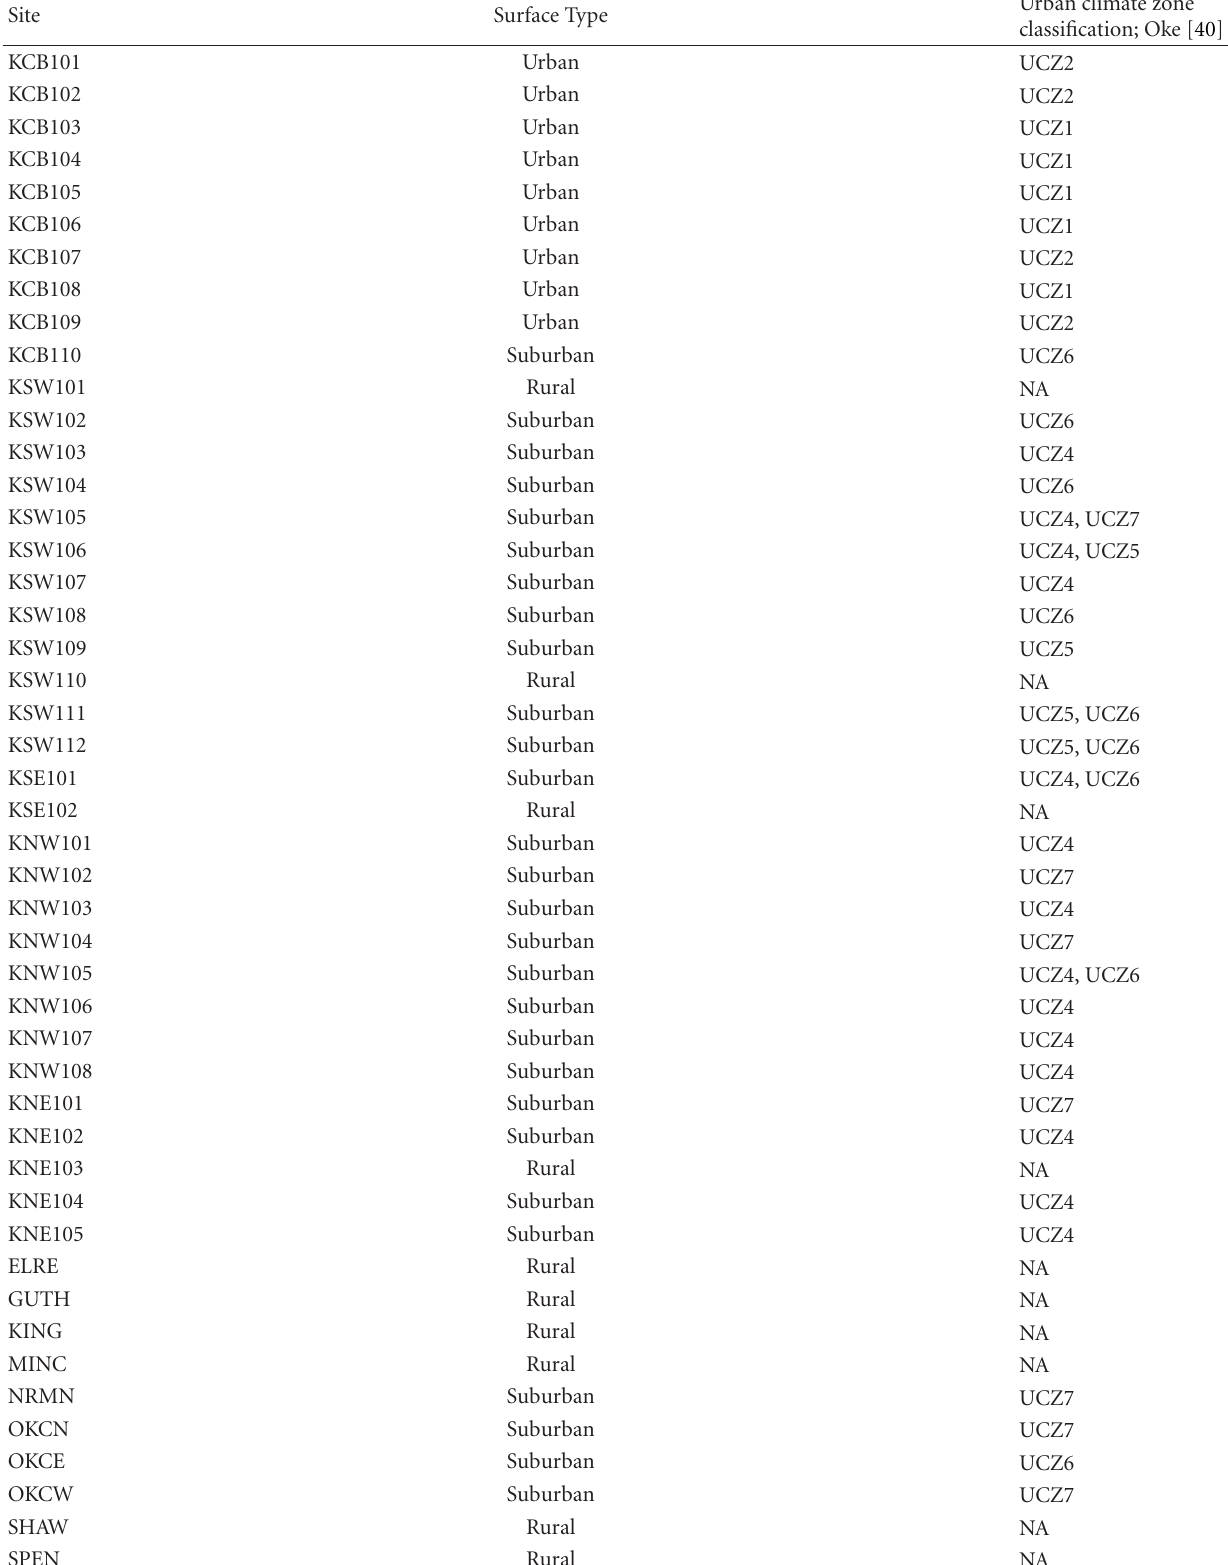
Table 1: The surface characteristics of stations used in the study along with urban climate zone classifications defined by Oke